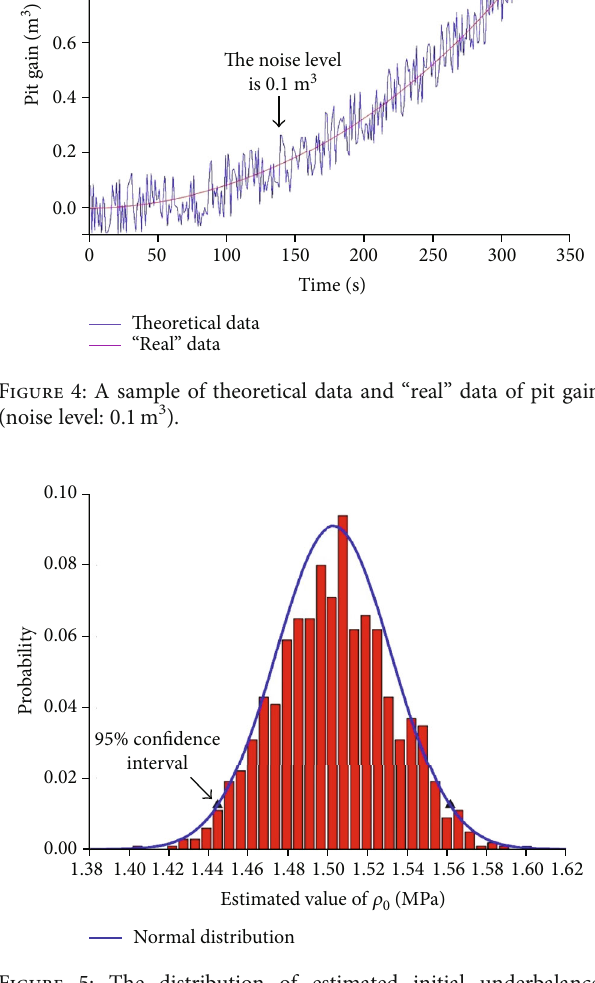
Figure 7: The distribution of inversion results with di ff erent initial underbalance